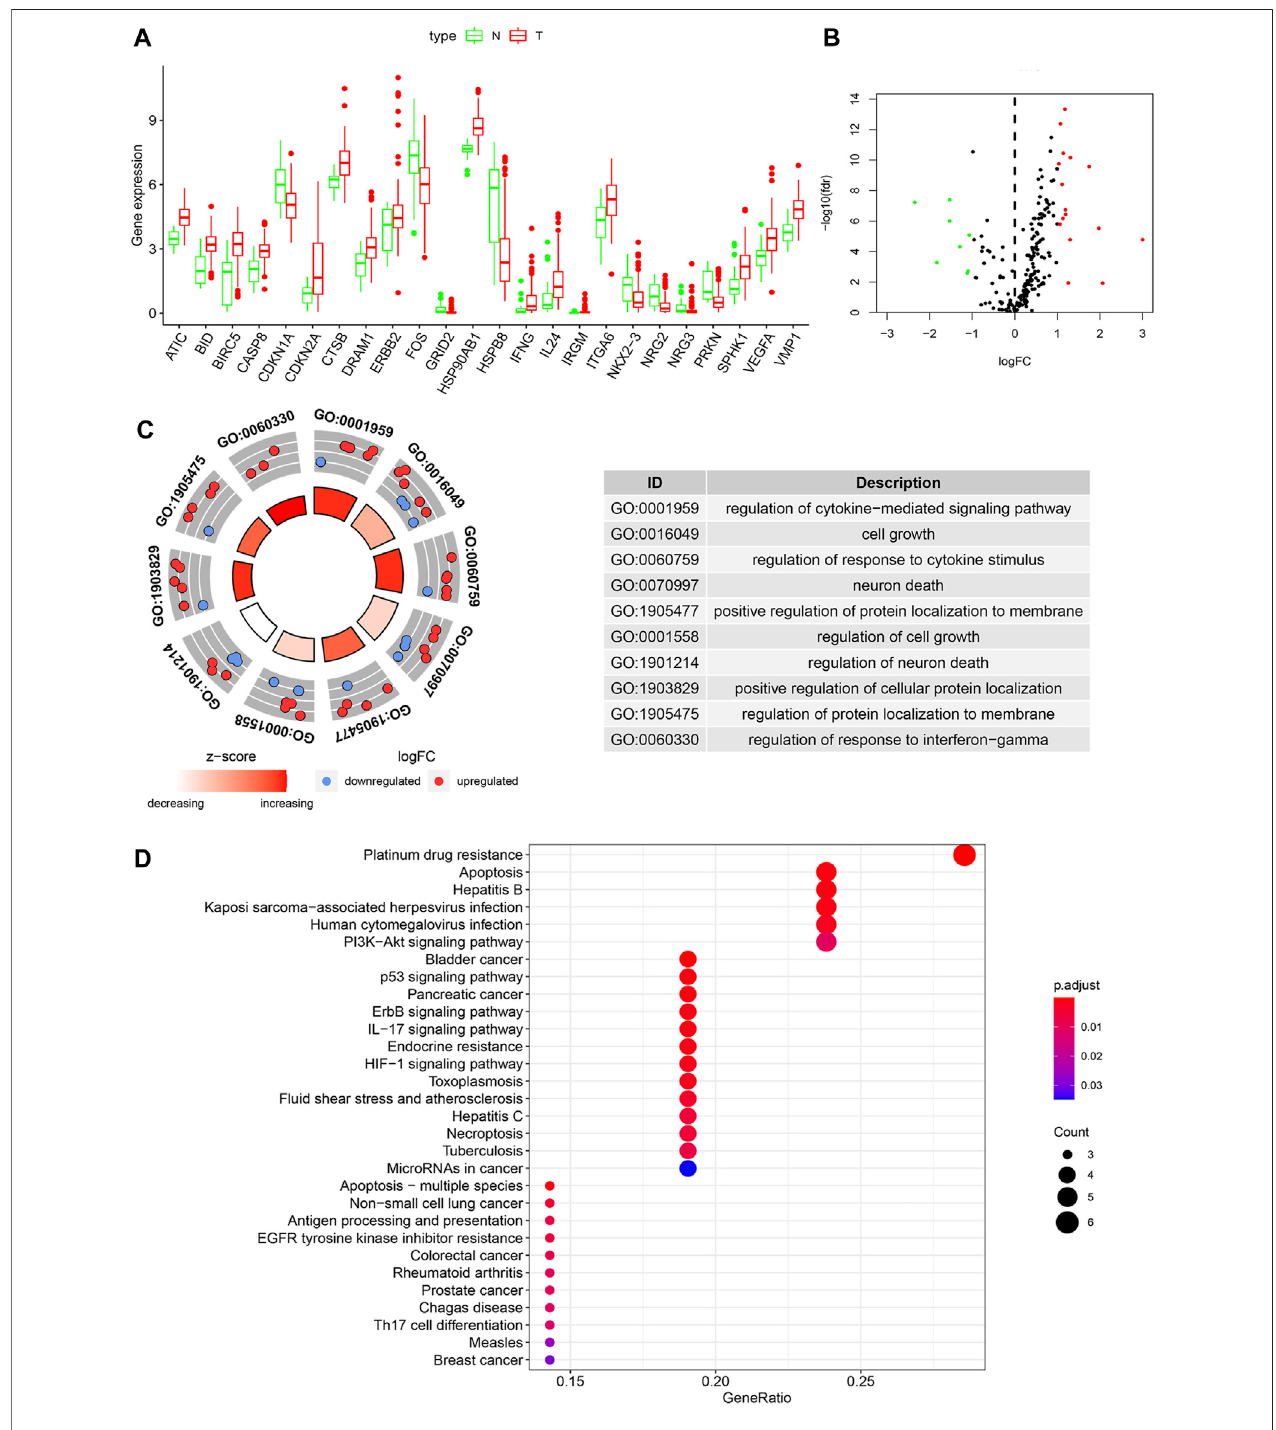
FIGURE 1 | The differentially expressed ARGs and function analysis in a chemotherapeutic group and normal tissues. (A) Visualization of the expression levels of the 24 differentially expressed ARGs. (B) Volcano plot of 221 ARGs. Red upregulation; Green downregulation. (C) GO analysis of 24 differentially expressed ARGs. (D) Bubble diagram of KEGG enrichment